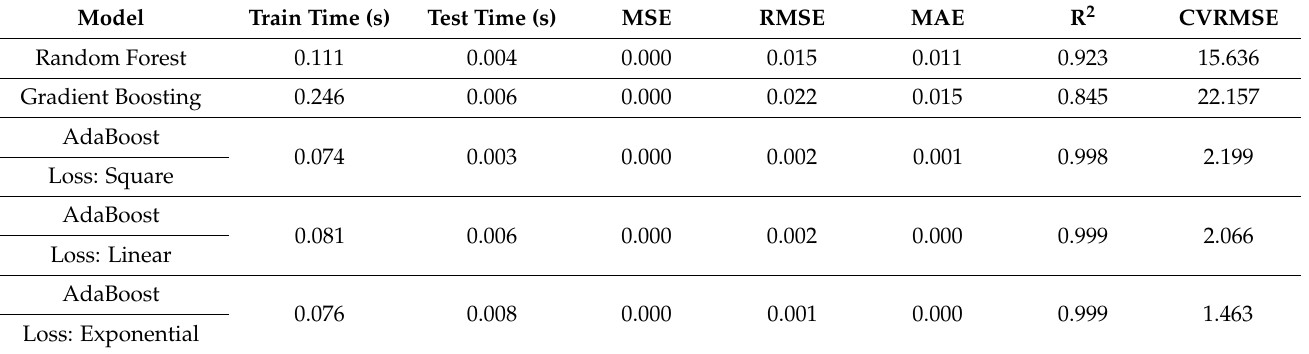
Table 8. Optimal